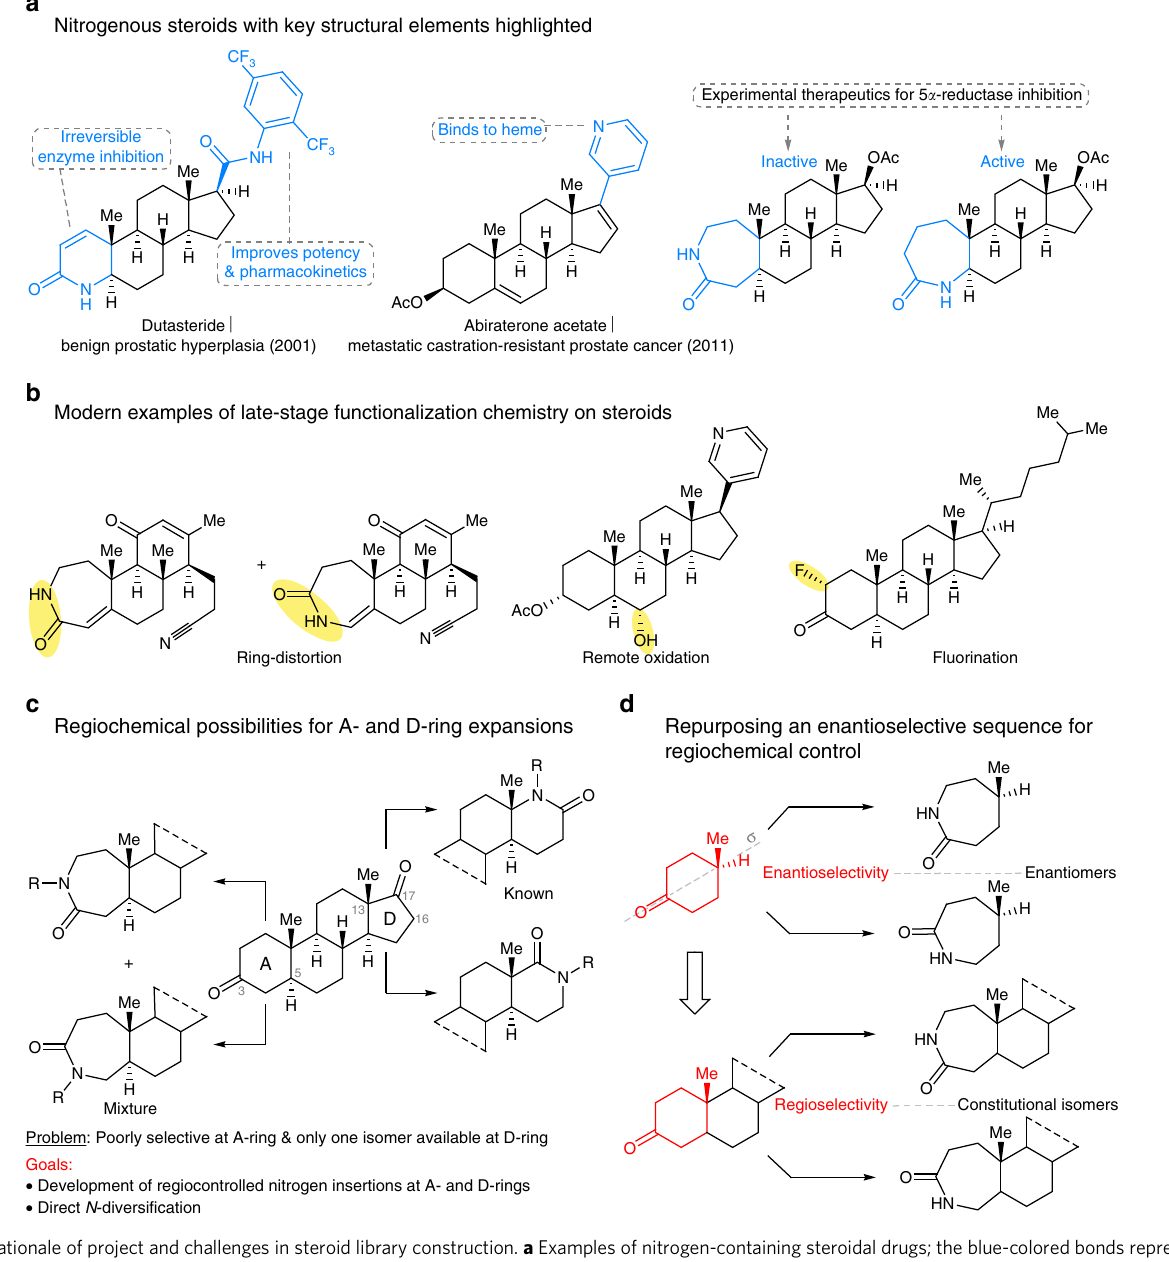
Fig. 1 Rationale of project and challenges in steroid library construction. a Examples of nitrogen-containing steroidal drugs; the blue-colored bonds represent A- and D-ring sites essential for biological activity. The site of substitution often has a profound effect on biological activity 41 . b Representative contemporary approaches to late-stage functionalization of steroids 9, 18, 19 . c Regiochemical challenges accompanying ring expansion reactions of 3- and 17-oxosteroids. d The relationship between enantiotopic group migration selectivity in a C-4 substituted cyclohexanone and regioselectivity in a